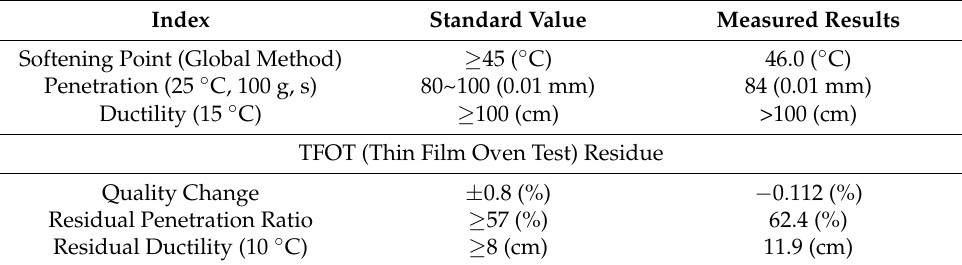
Table 1. Properties of 90# matrix